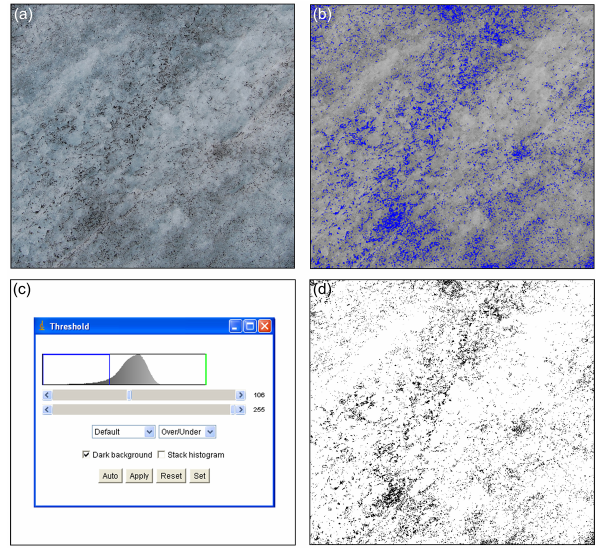
Figure 3. Example of the procedure followed in image analy- sis: (a) original cut frame; (b) 8bit conversion and discrimination between the debris-covered (in blue) and debris-free ice surface; (c) definition of the threshold; (d) calculated debris cover